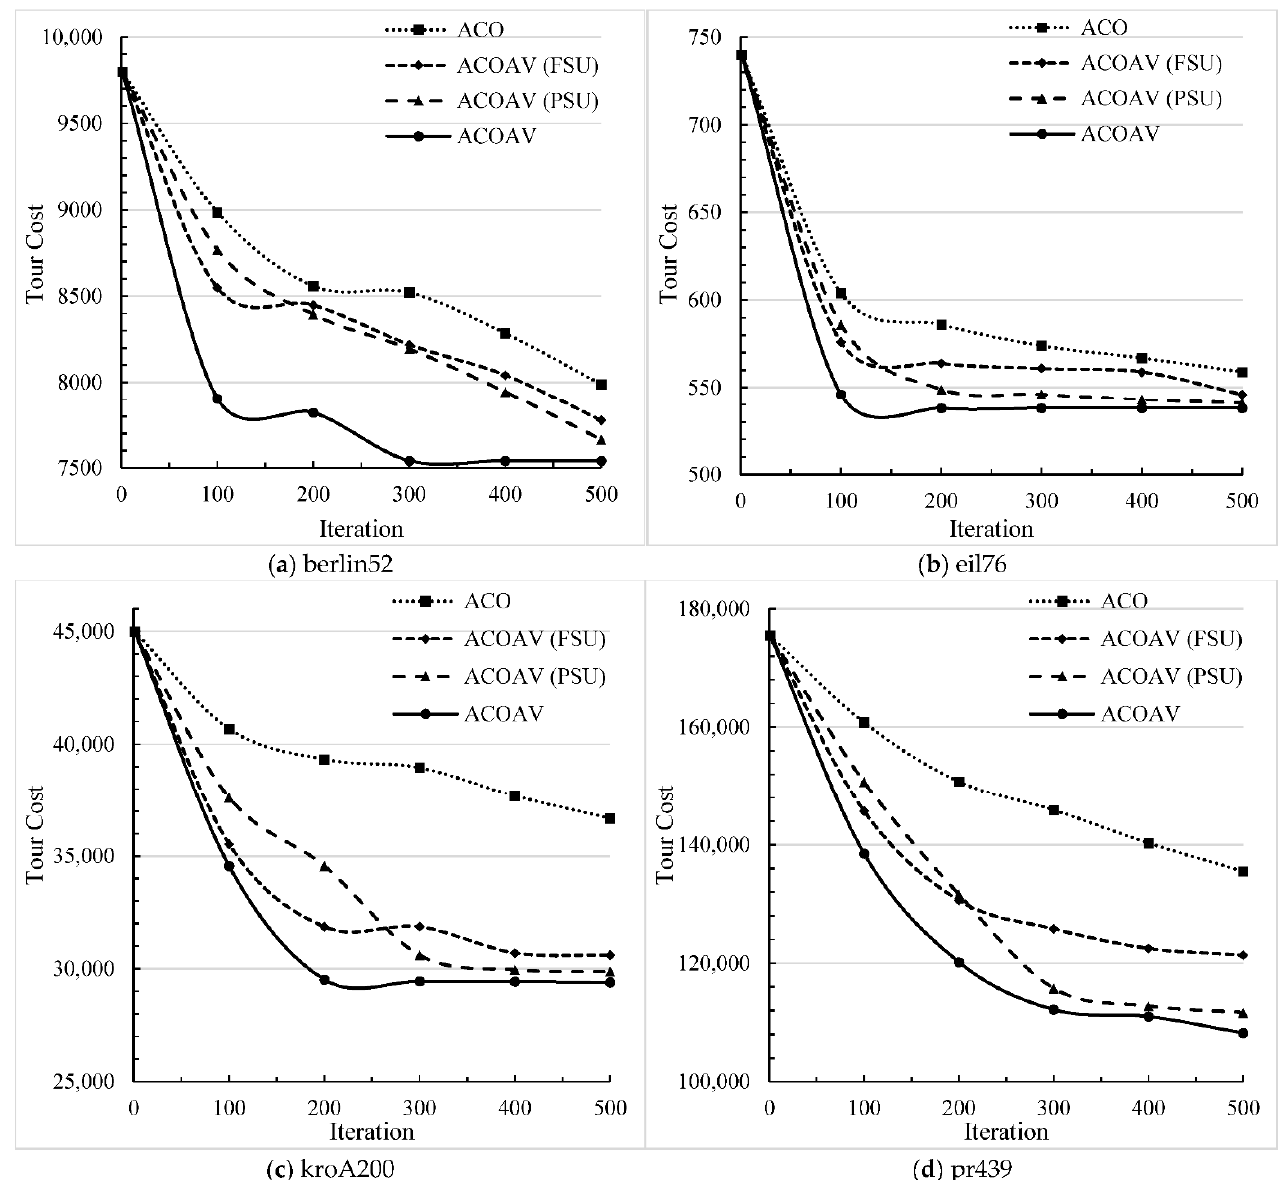
Figure 4. Tour cost improvement over iterations for conventional ACO, with different methods with adaptive visibility in different modes. ACOAV (FSU) is ACO + AV with full solution update mode, ACOAV (PSU) is ACO + AV with partial solution update mode, and ACOAV is the proposed model as ACOAV (PSU) + 3-Opt.